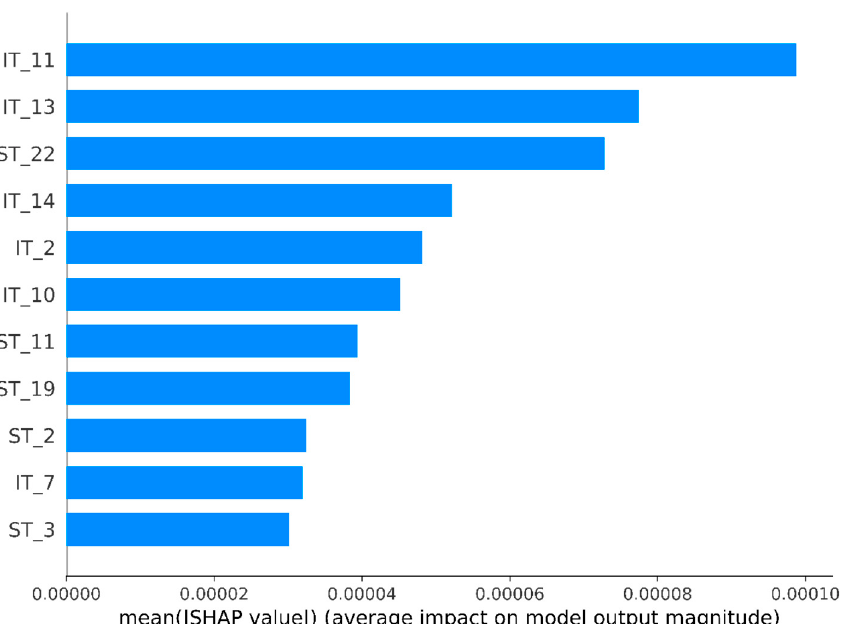
Figure 13. Feature importance at the input to PIDNN, ranked by SHAP values, for SKD system without LLC block (System A).